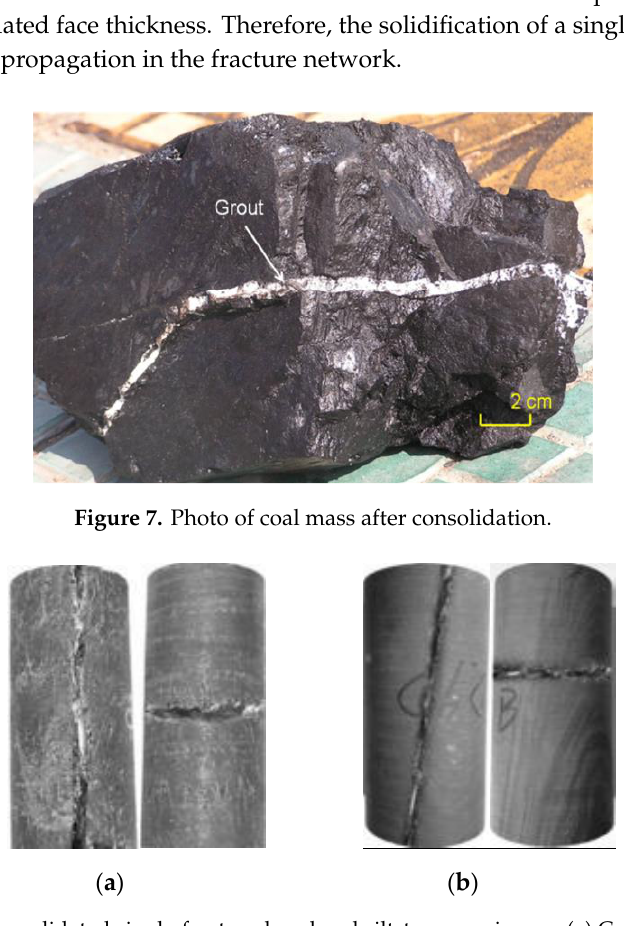
Figure 8. Typical consolidated single-fractured coal and siltstone specimens. ( a ) Coal and ( b ) siltstone.